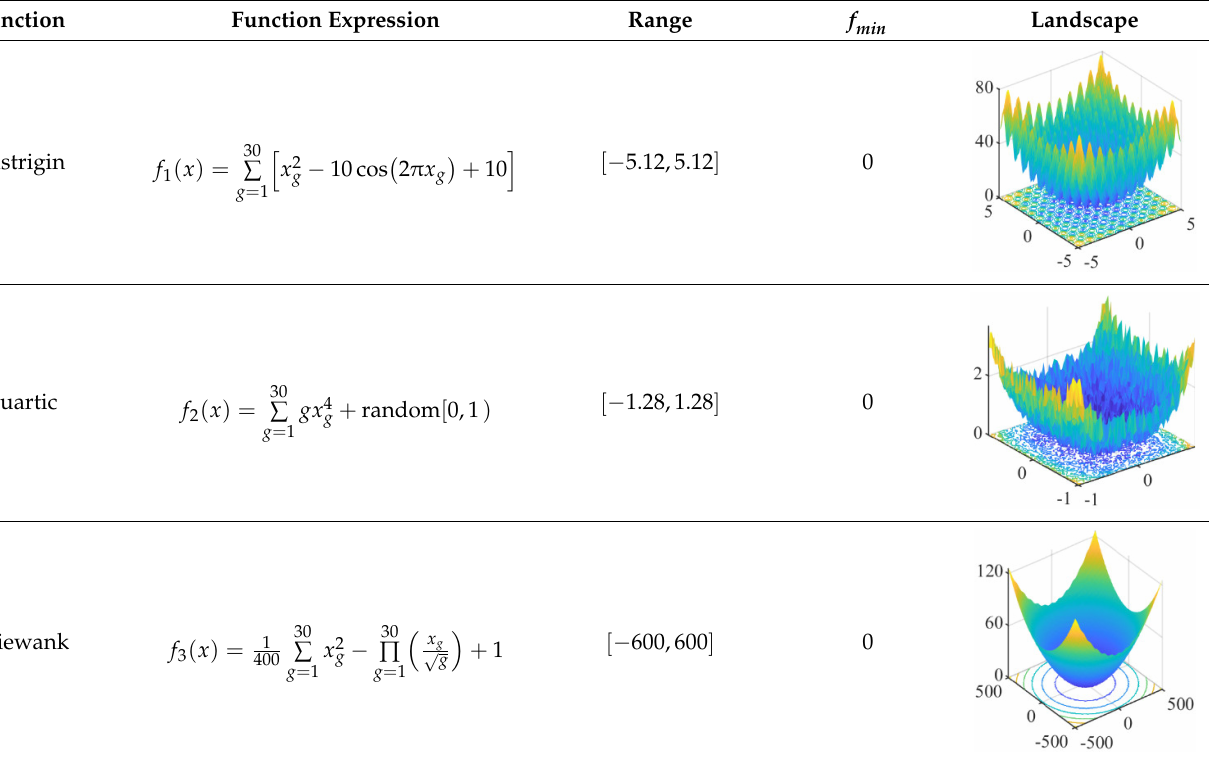
Table 1. Three classic benchmark